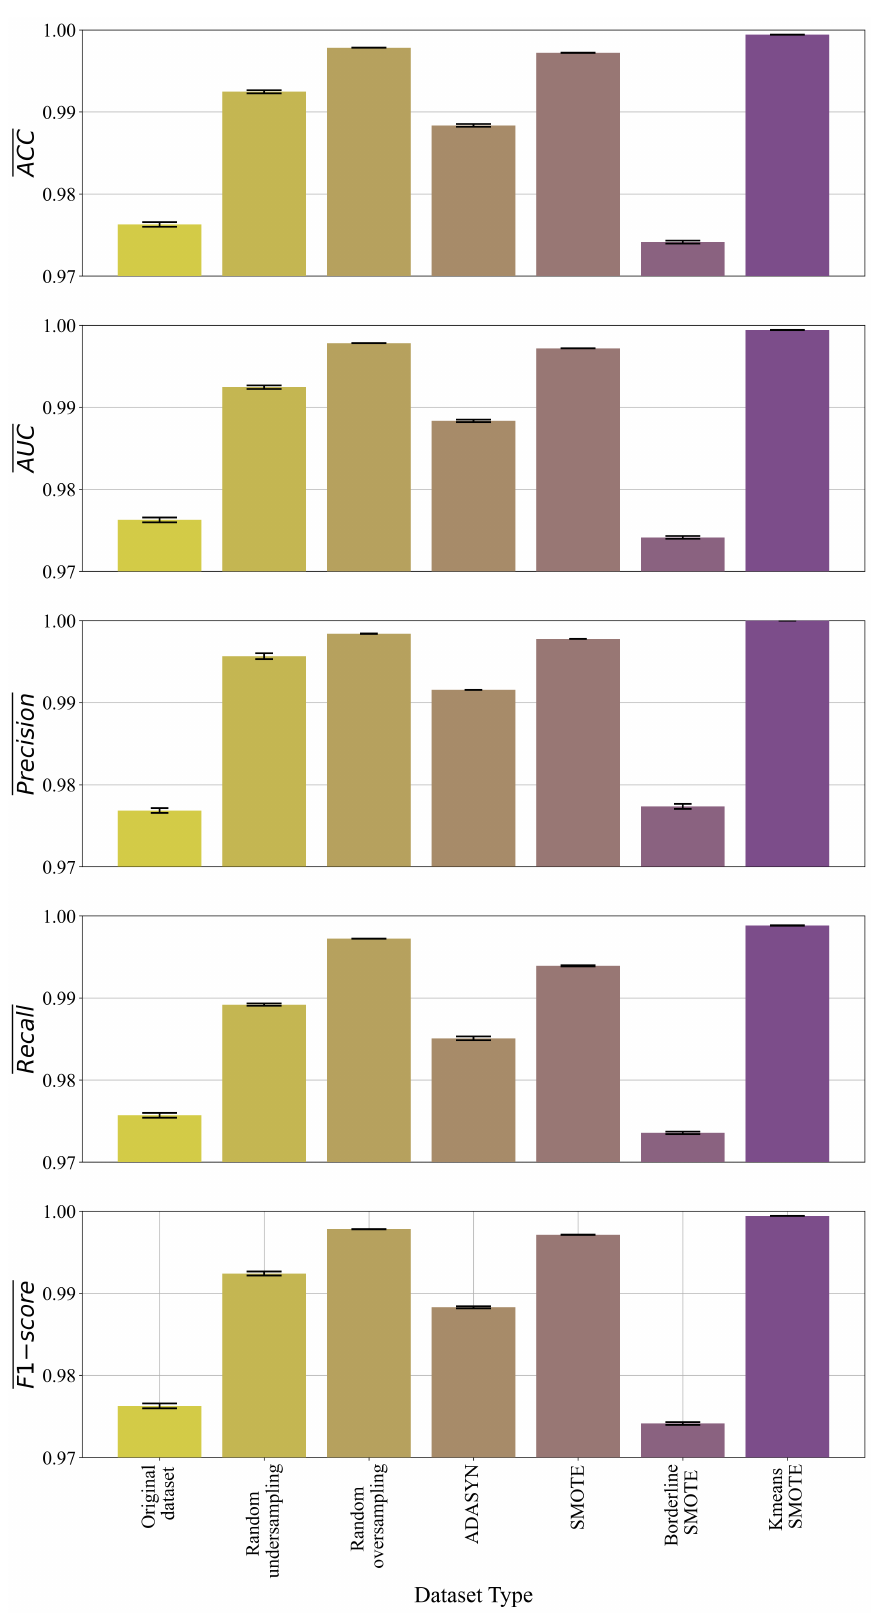
Figure 7. The mean and standard deviation of evaluation metric values achieved with GPSC, random hyperparameter search, and 5-fold cross-validation on each dataset